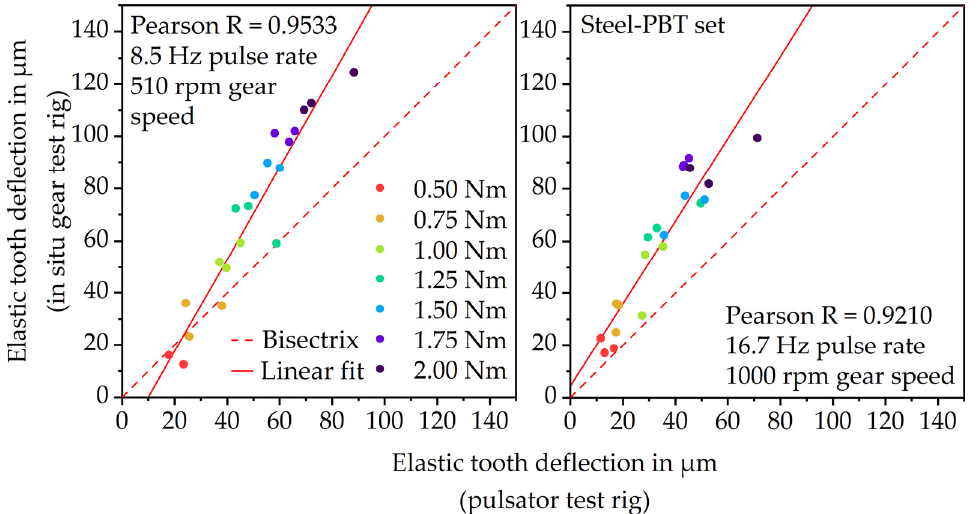
Figure 8. Correlation between the elastic tooth deflection measurement via in situ gear test rig and pulsator test rig.